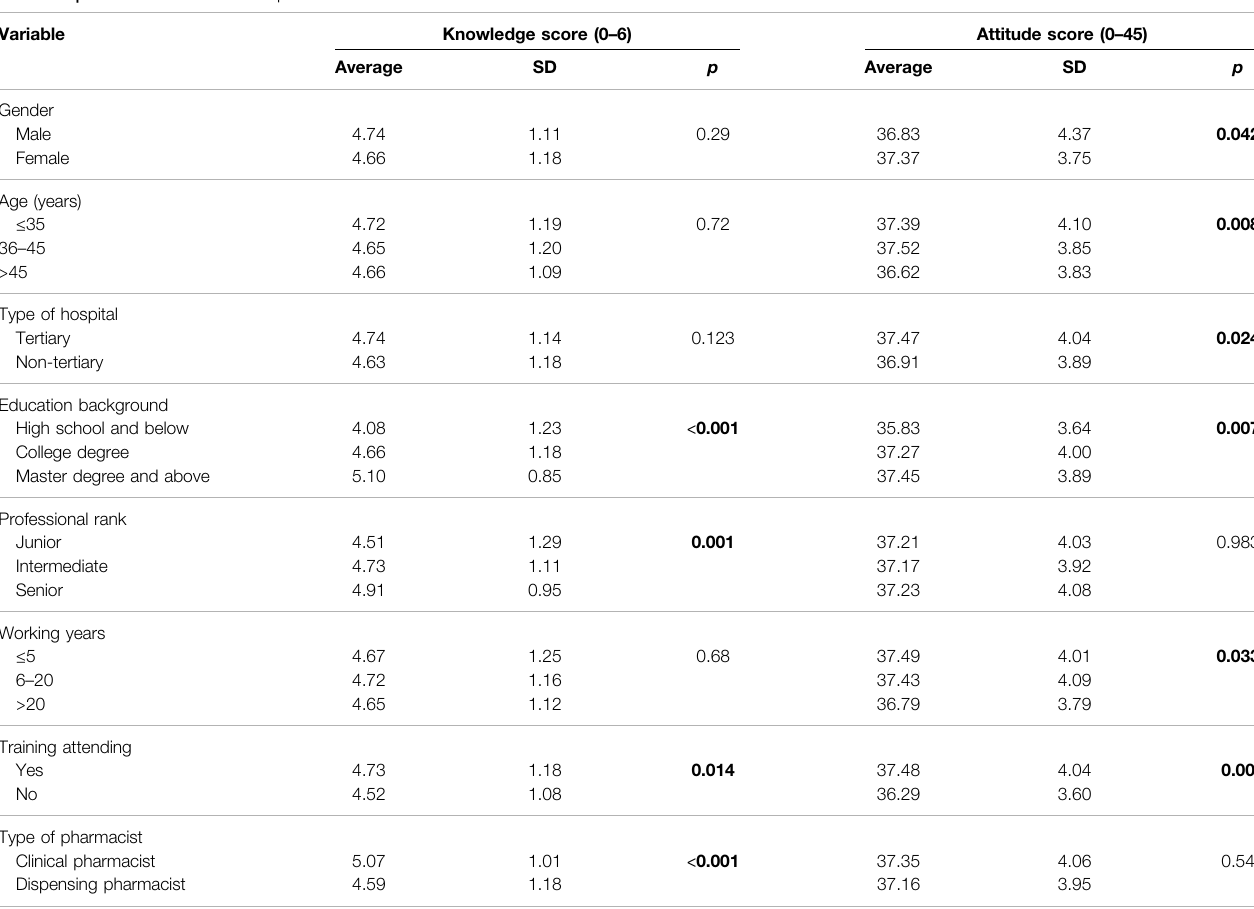
TABLE 3 | The relation between the pharmacist ’ s characteristics and KAP.